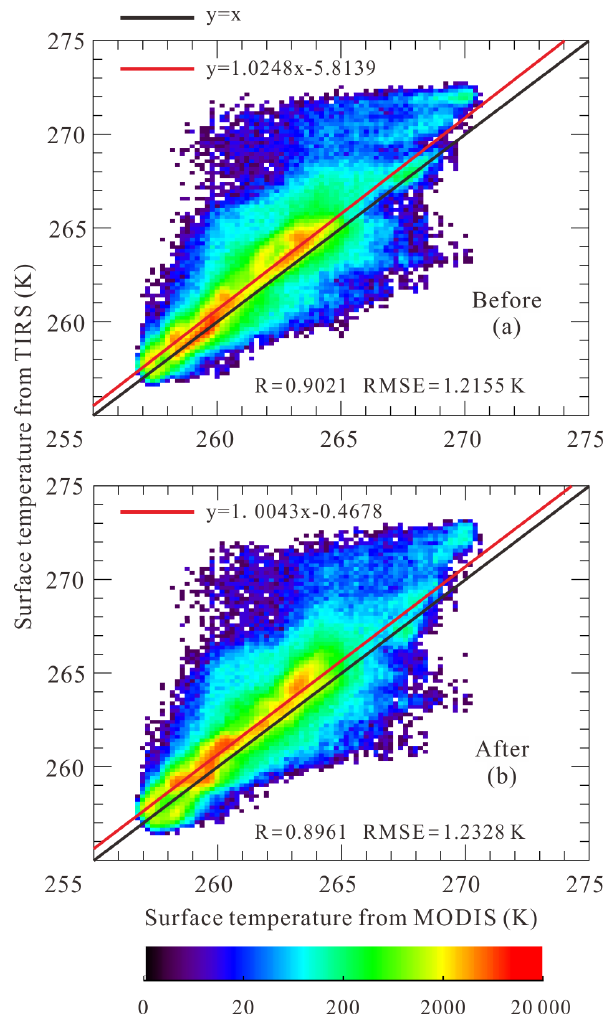
Figure 7. Correlation between IST from MODIS and Landsat-8 TIRS before and after correction for stray light. Black lines are ref- erence for y = x , and red lines are linear regression lines with a fitting equation. Number density of scattered points is marked by color. (a) Scatter plot of IST from MODIS and Landsat-8 TIRS us- ing split-window algorithm. (b) Scatter plot of IST from MODIS and corrected IST from Landsat-8 TIRS.